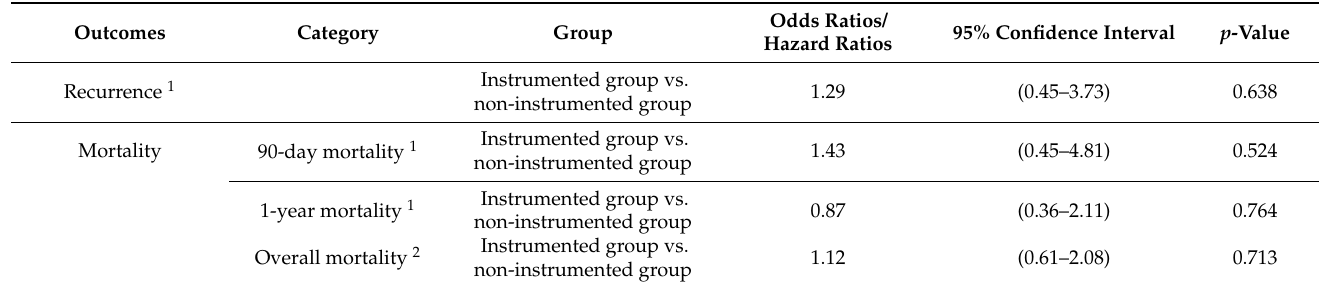
Table 5. Clinical risks of additional spinal instrumentation in the matched surgical cohort: multivariable analysis. Outcomes